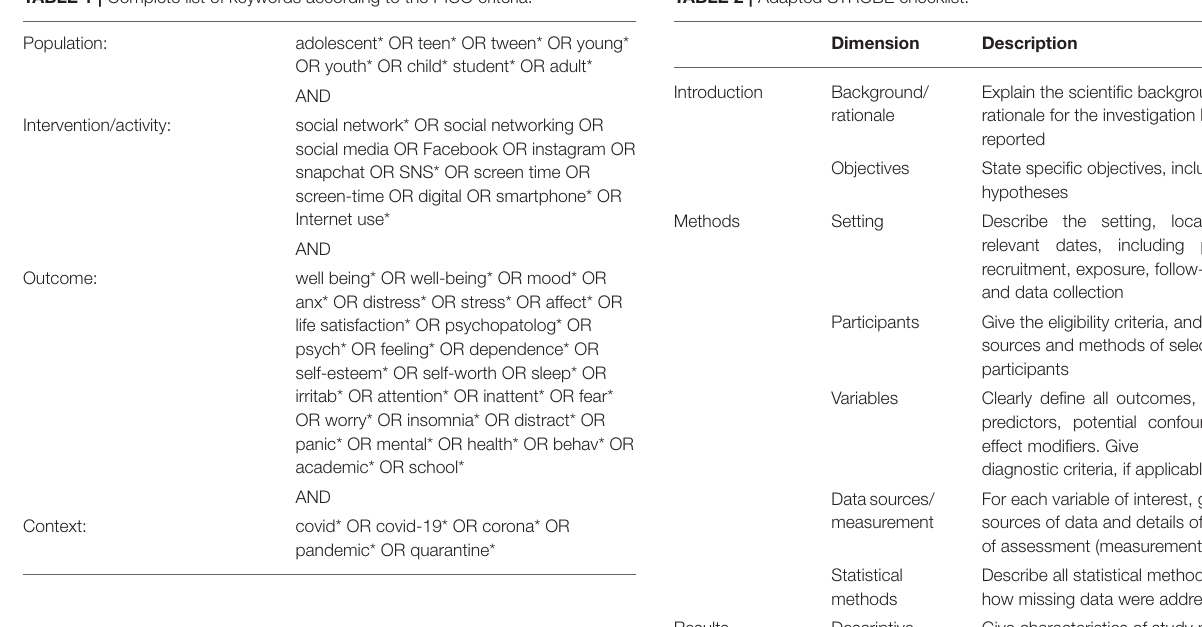
TABLE 2 | Adapted STROBE